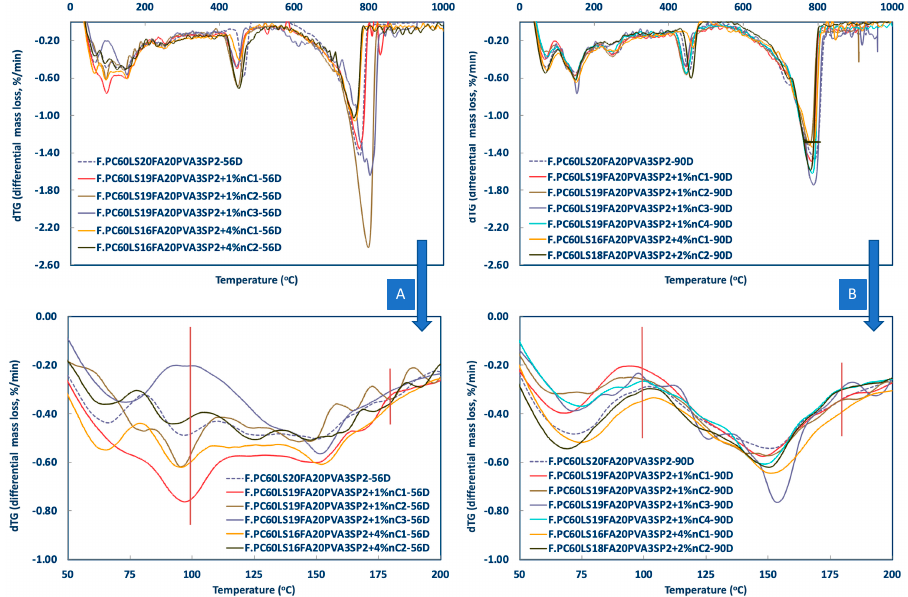
Figure 10. Differential mass loss between 100–200 °C of nMt and fibre reinforced cementitious nanocomposites at ( A ) Day 56 and ( B ) Day 90.